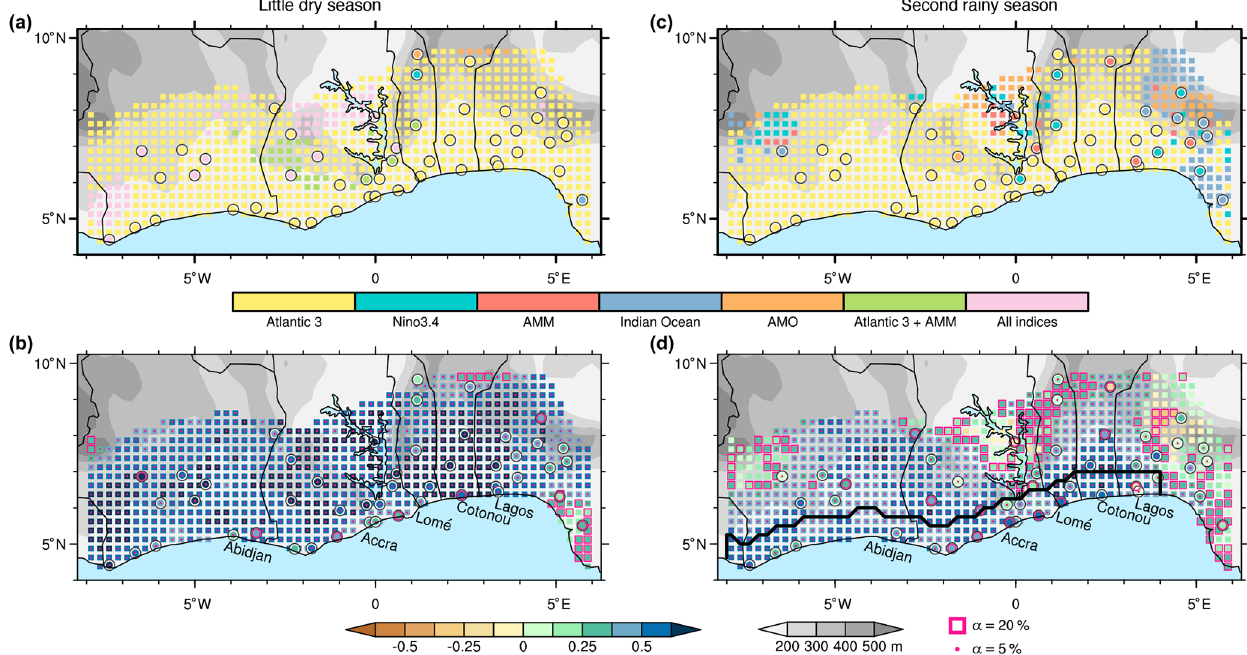
Figure 2. Optimal linear model. (a) Combination of climate indices yielding the best results with respect to the leave-one-out cross-validation procedure as described in Sect. 2.2 for the LDS. Each of the single-index models (Atlantic 3, Niño3.4, AMM, AMO) can be found. The only combinations of indices with better results are Atlantic 3 with AMM and the combination of all five indices. (b) Pearson’s correlation coefficient of the optimal linear model with the original rainfall time series for the LDS. Panels (c) and (d) are the same as (a) and (b) but for the SRS. The coastal strip is marked by a black line in (d) . All panels show data from 1983–2015 for the CHIRPS (coloured pixels) and station data (coloured circles). Statistically significant correlations in (b) and (d) are marked with pink borders of pixels and stations for the α = 20% level and a pink dot in the middle for the α = 5% level,